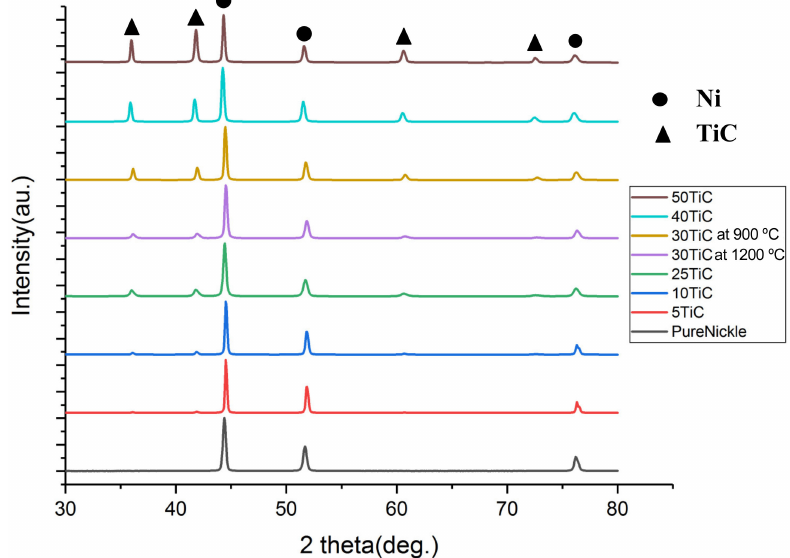
Figure 1. XRD graph and peak index of Pure Ni, Ni-5TiC, Ni-10TiC, Ni-25TiC, Ni-30TiC at 900 ◦ C, Ni-30TiC at 1200 ◦ C, Ni-40TiC and